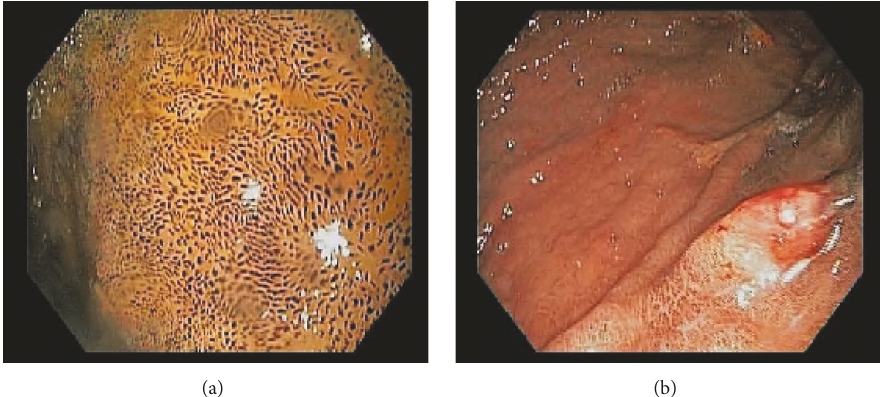
Figure 1: Endoscopic image showing brown-black speckled spots throughout the mucosa of the duodenum (a) and gastric polyp (b).